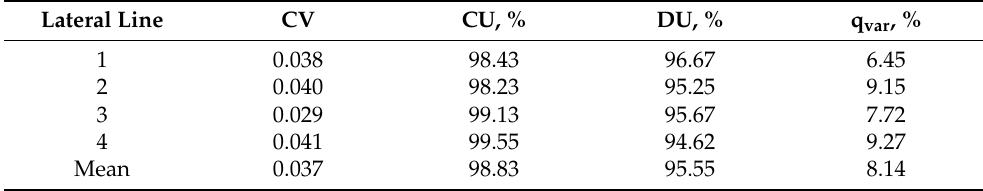
Table 7. Drip irrigation network evaluation calculating coefficient of variation (CV), Christiansen’s coefficient of uniformity (CU), distribution uniformity (DU), and flow rate variation (q var ) at 1 bar operating